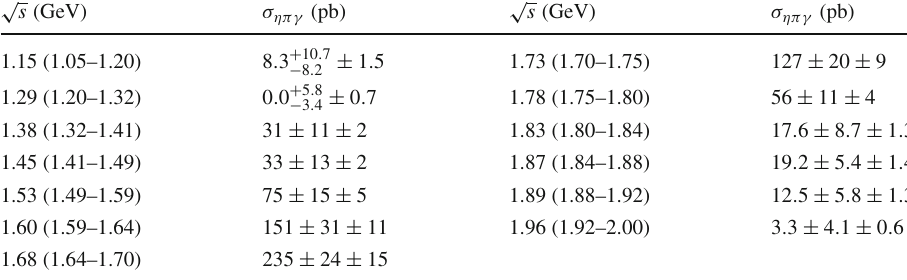
Table 5 Weighted average √ s ) for the interval energy ( indicated in parentheses, and the total e + e − → ηπ 0 γ cross section ( σ ηπγ ). For the cross section, the first error is statistical, the second is